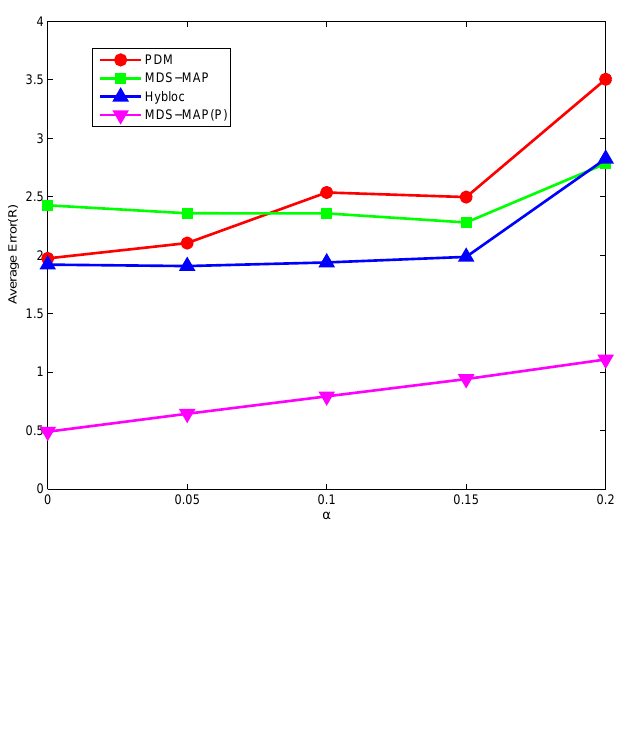
Figure 14 . 5 Clustered Anchors, Average Connectivity=11.68, C-shaped Networks.